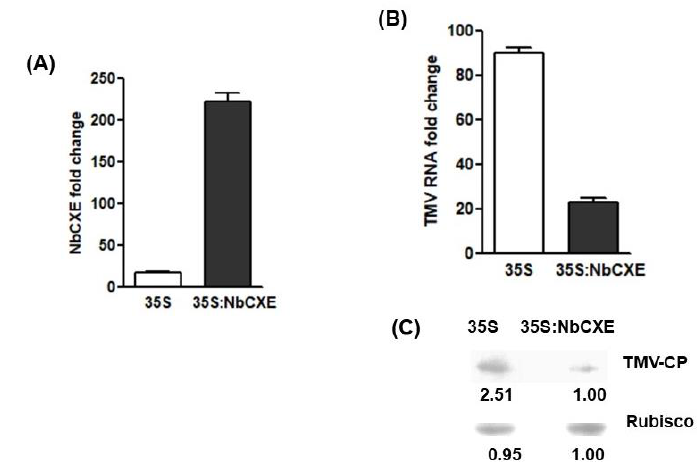
Figure 2. ( A ) After transient over-expression of NbCXE in N. benthamiana plants, the transcriptional level of NbCXE was increased at 3 days post-infiltration. ( B ) TMV RNA accumulation in the NbCXE-overexpressed leaves was significantly lower than that in the control plants. ( C ) NbCXE transient overexpressed leaves accumulated a lower level of TMV CP, as compared with that of the control plants.